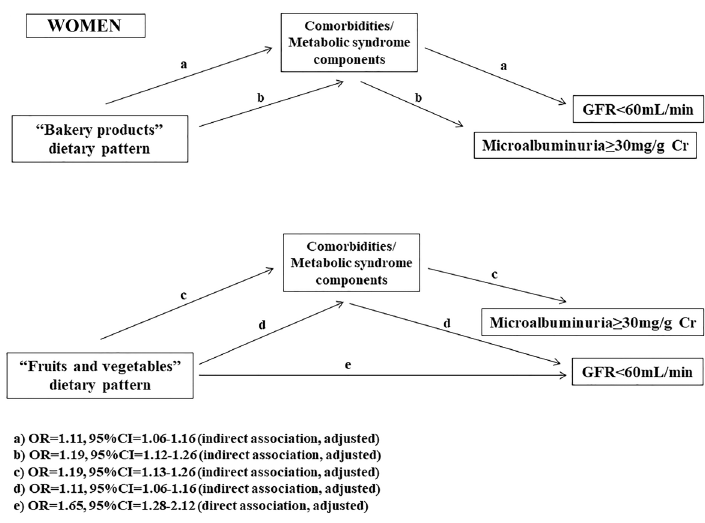
Figure 3. Results of mediation analysis. Association between dietary patterns and renal function mediated by metabolic syndrome for women (analysis adjusted for age, gender, ethnicity, and level of schooling). Comorbidities/metabolic syndrome components: elevated waist circumference, hypertension, diabetes, dyslipidemia, and